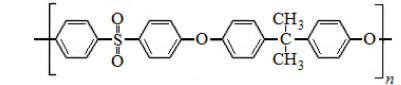
O ; 4 – aluminum cover; 5 – cup; 6 – 2 5